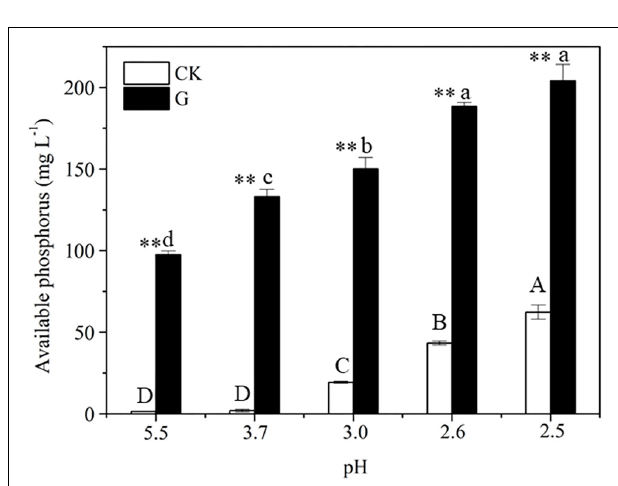
FIGURE 6 | Effect of gluconic acid on Al-P solubilization. The concentration of available P in uninoculated culture medium containing AlPO 4 as the P source was determined after addition of 15 g L − 1 gluconic acid at pH 5.5, 3.7, 3.0, 2.6, and 2.5. The pH of the culture medium was manually adjusted as in Figure 4A at 0, 12, 24, 36, and 48 h. Vertical bars represent standard deviations of the means ( n = 3). Different capital and lowercase letters above columns indicate significant differences ( p < 0.05) among different pHs without and with gluconic acid, respectively. Asterisks above columns indicate significant differences ( p < 0.01) between CK and gluconic